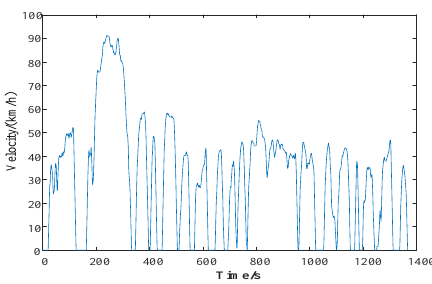
Figure 11. FUDS (federal urban driving schedule) driving cycle.